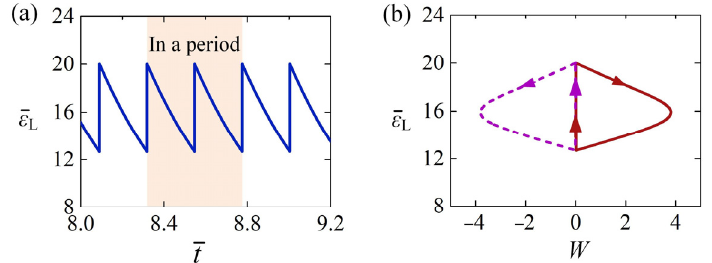
Figure 4. ( a ) The time history of light-induced expansion of the rod shown in Figure 3c,d. ( b ) The dependence of light-induced expansion on lateral displacement in one cycle of self-sustained Euler buckling. The light-induced expansion of the rod changes periodically with time during the dynamic Euler buckling.